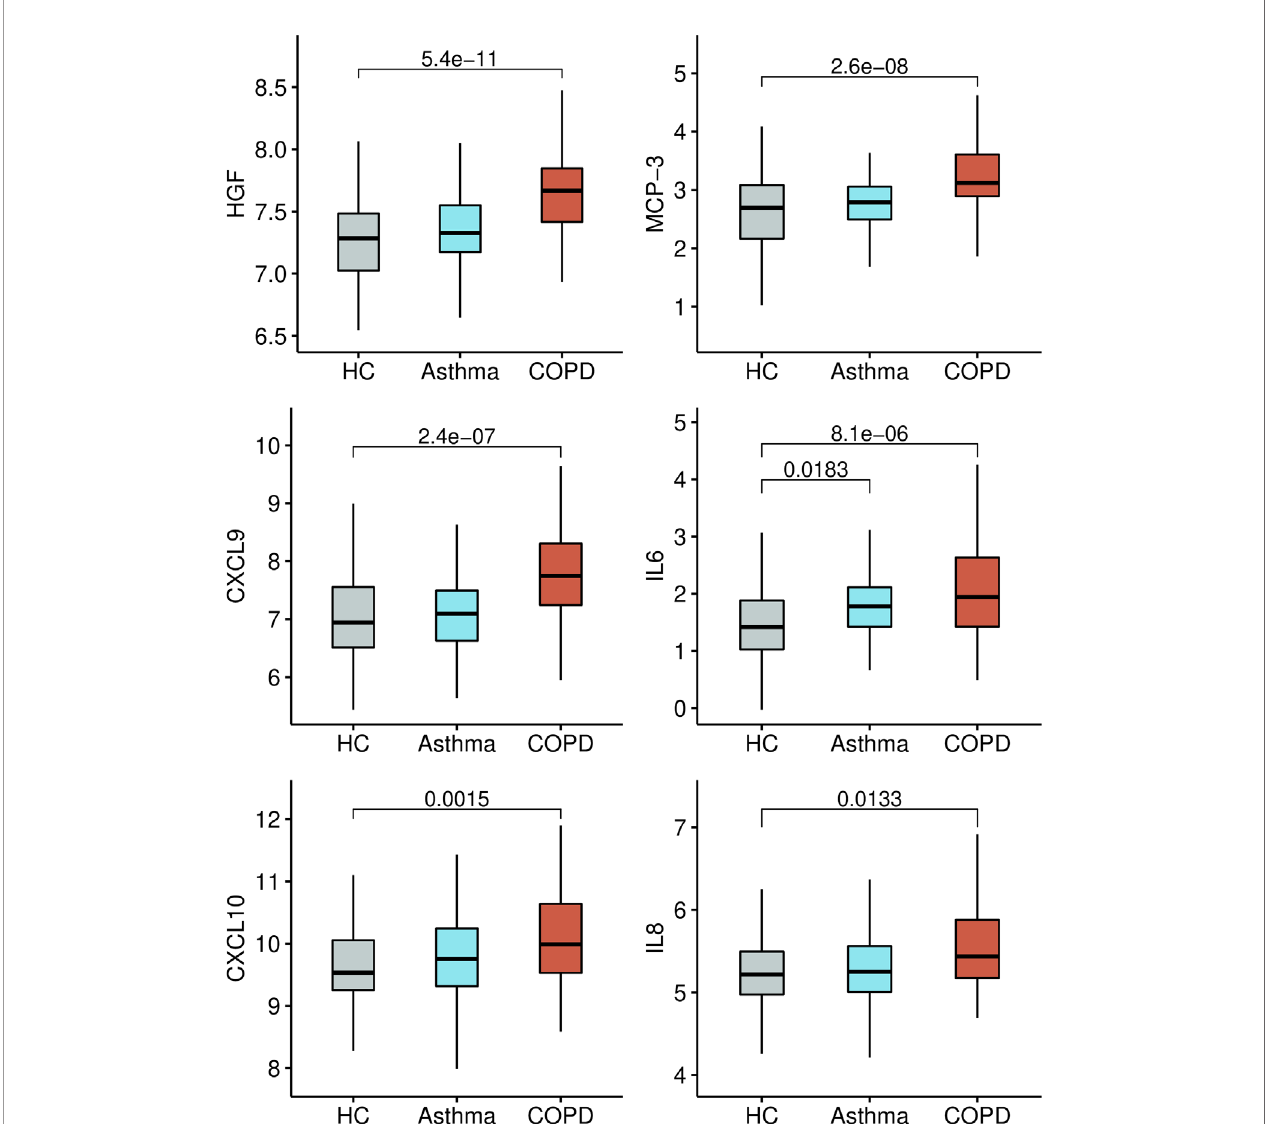
FIGURE 7 | Boxplots with the normalized protein levels (log 2 scale) of six proteins associated with severe COVID-19 in non-infected healthy controls (HC), asthma and COPD